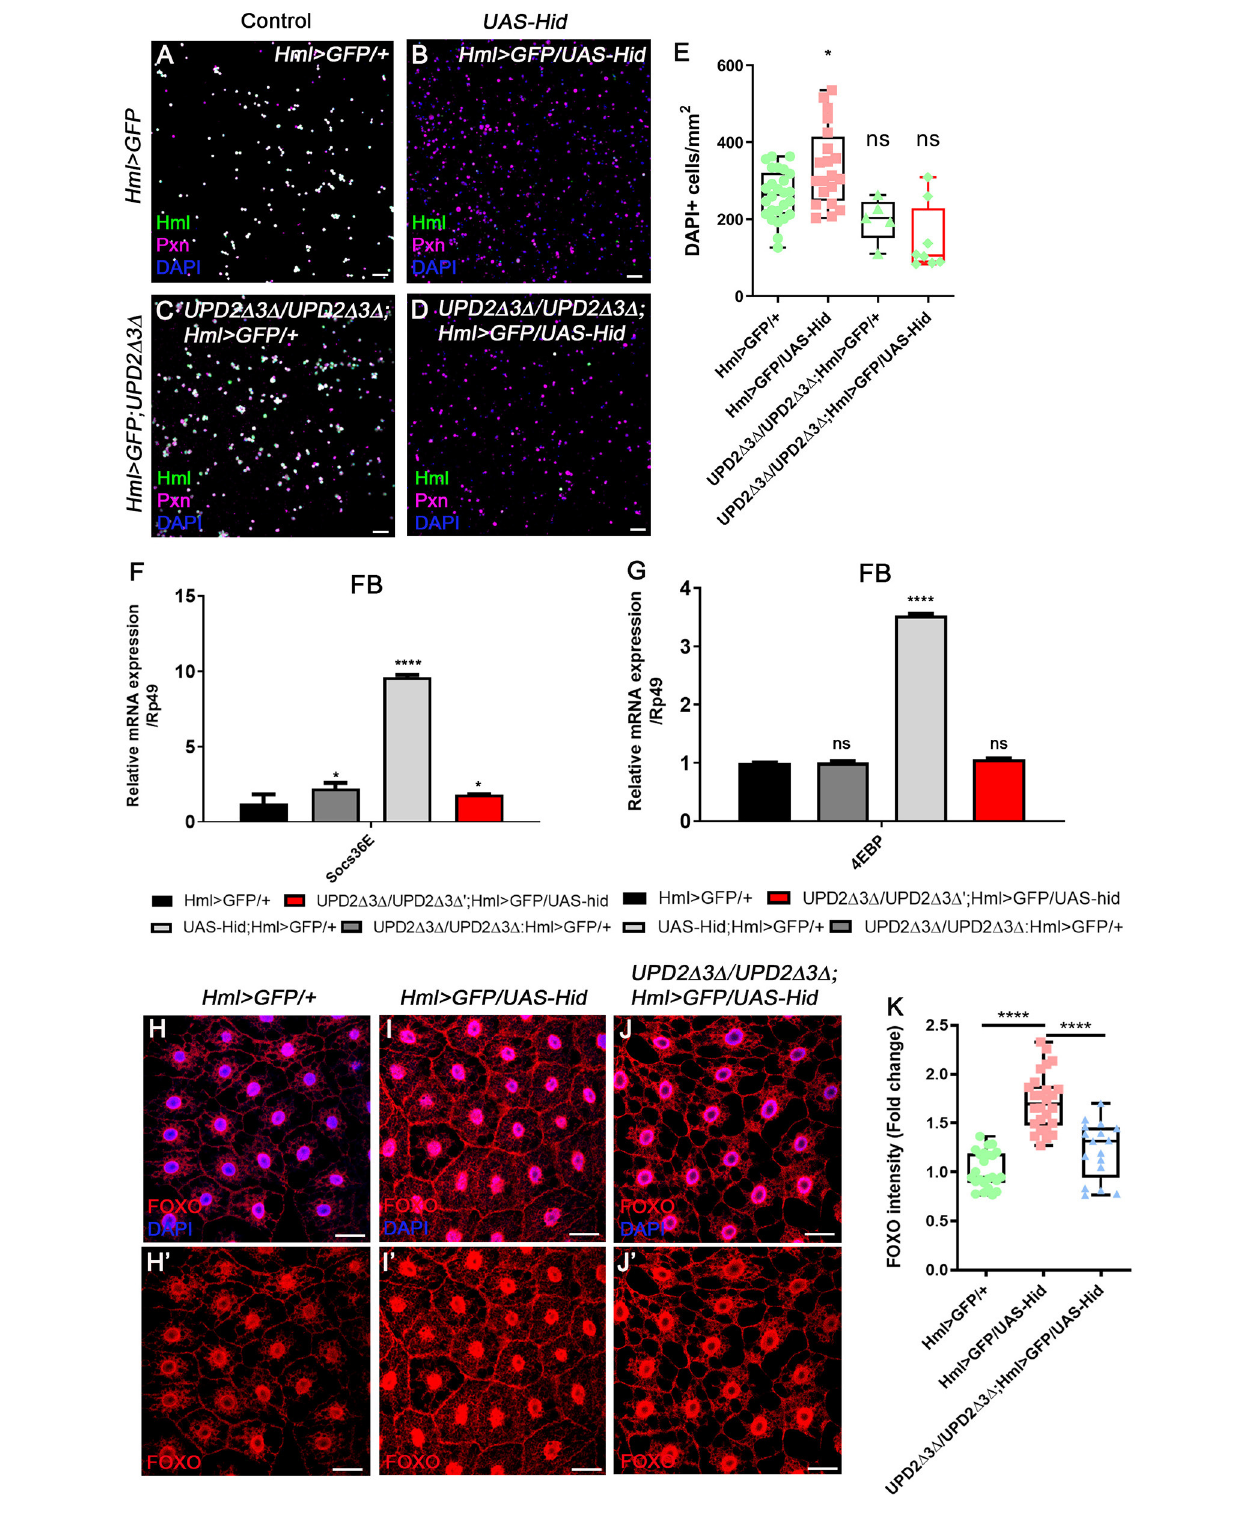
FIGURE 4 | upd2 1 upd3 1 mutants rescue the phenotypes caused by genetic ablation of Hml + hemocytes. (A–E) The number of total hemocytes is decreased in upd2 1 upd3 1 ; Hml-Gal4 UAS-hid background. Compared to wild types (A) , overexpression of hid in Hml + hemocytes ( Hml-Gal4 UAS-hid ) induces the number of